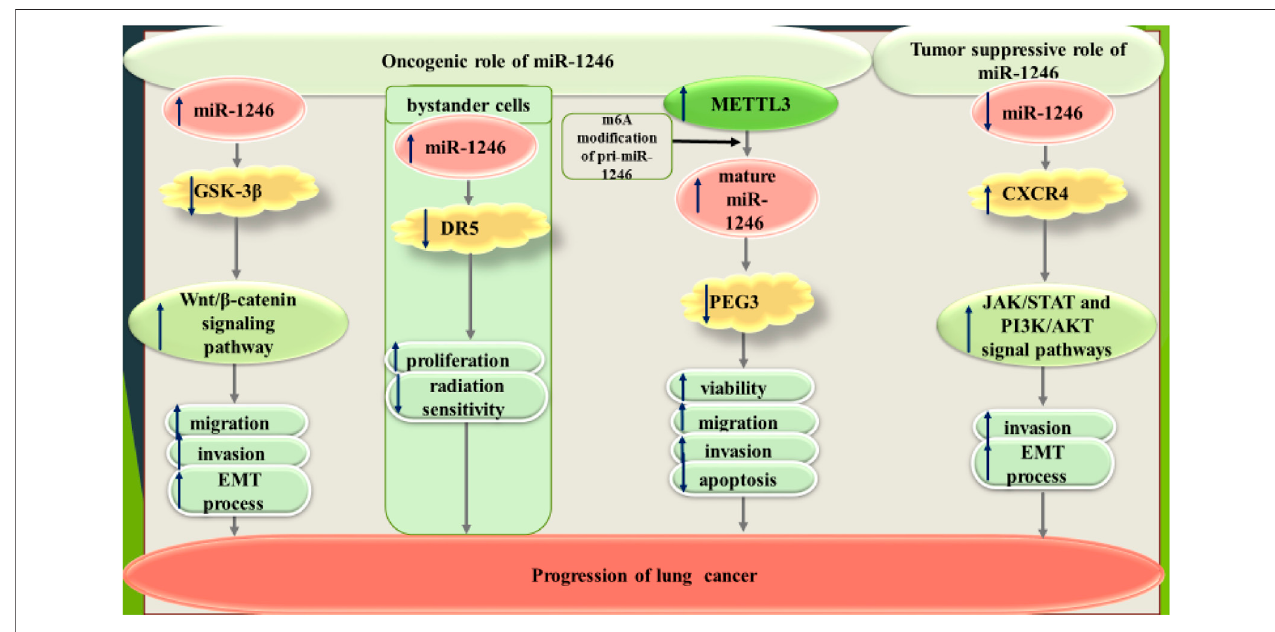
FIGURE 2 | Dual roles of miR-1246 in lung